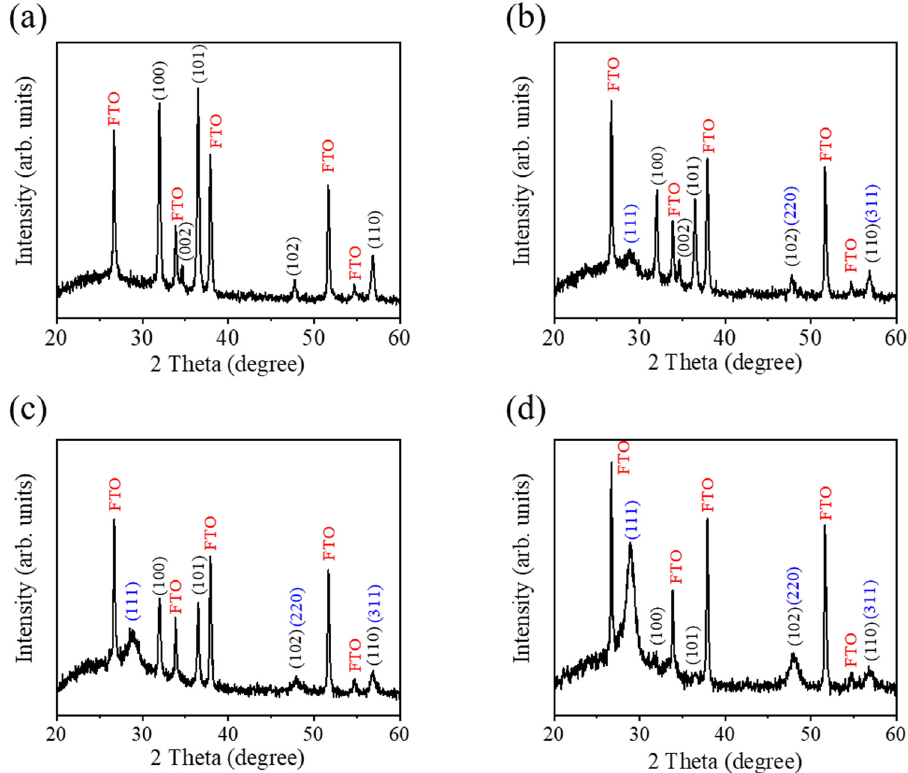
Figure 2: XRD patterns of various products: ( a ) ZnO template, ( b ) ZS - 1, ( c ) ZS - 2, and ( d ) ZS - 3. The ZnO and ZnS crystallographic planes are marked with black and blue,